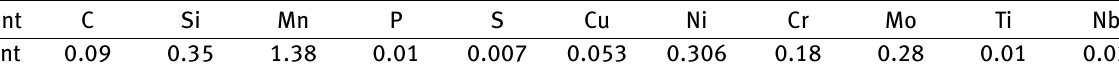
Table 1: Chemical composition of Nb-bearing pipeline steel (wt. %).